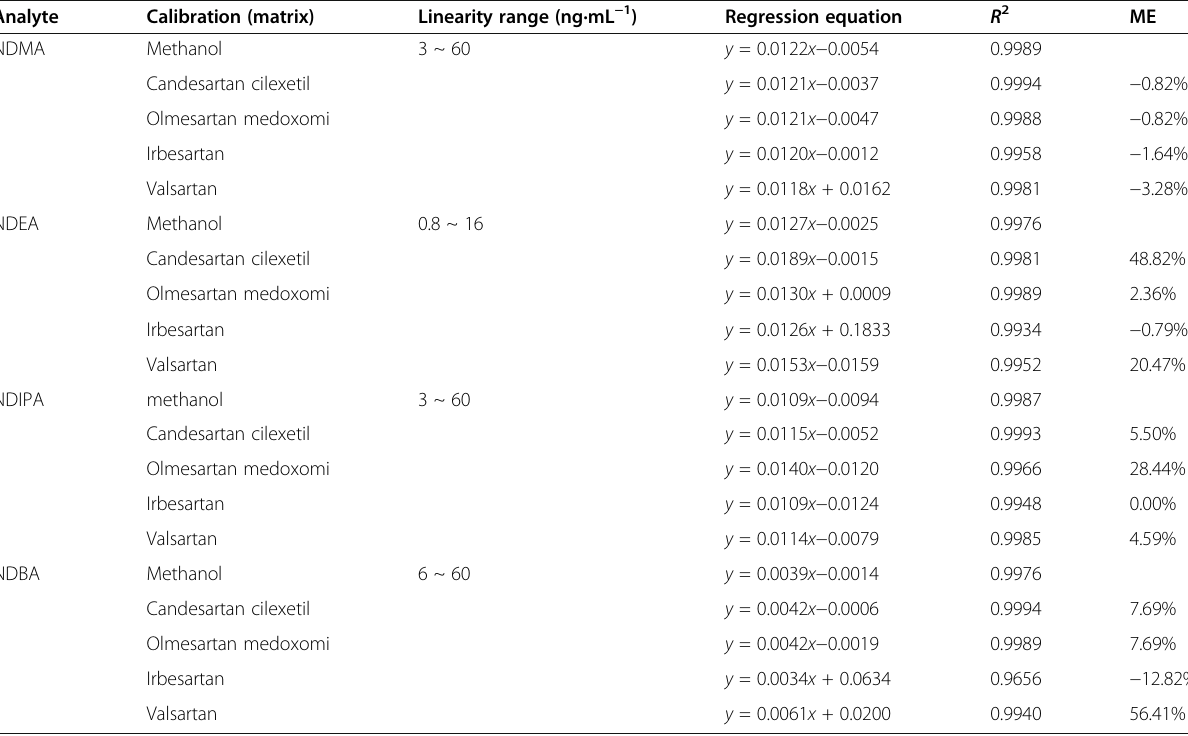
Table 3 Comparison of the calibration curves and calculation of matrix effect (ME) for N-nitrosamines in solvent and in sartan matrices